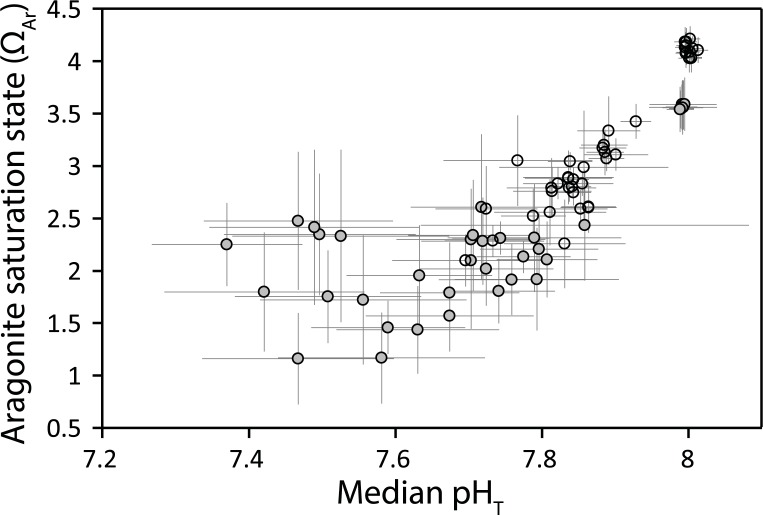
Median pHT and saturation state of aragonite (ΩAr) from the 88 settlement tiles.Median n = 8 pH and 5 ΩAr measures per tile. White points are from Upa-Upasina, grey are from Dobu. Error bars are standard errors.